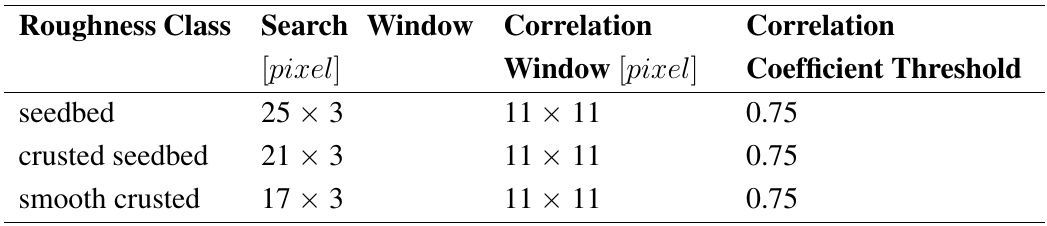
Table 4. Matching strategies used during DSM generation as required by LPS based on a pixel size in ground space of 0.57 mm in the x, y